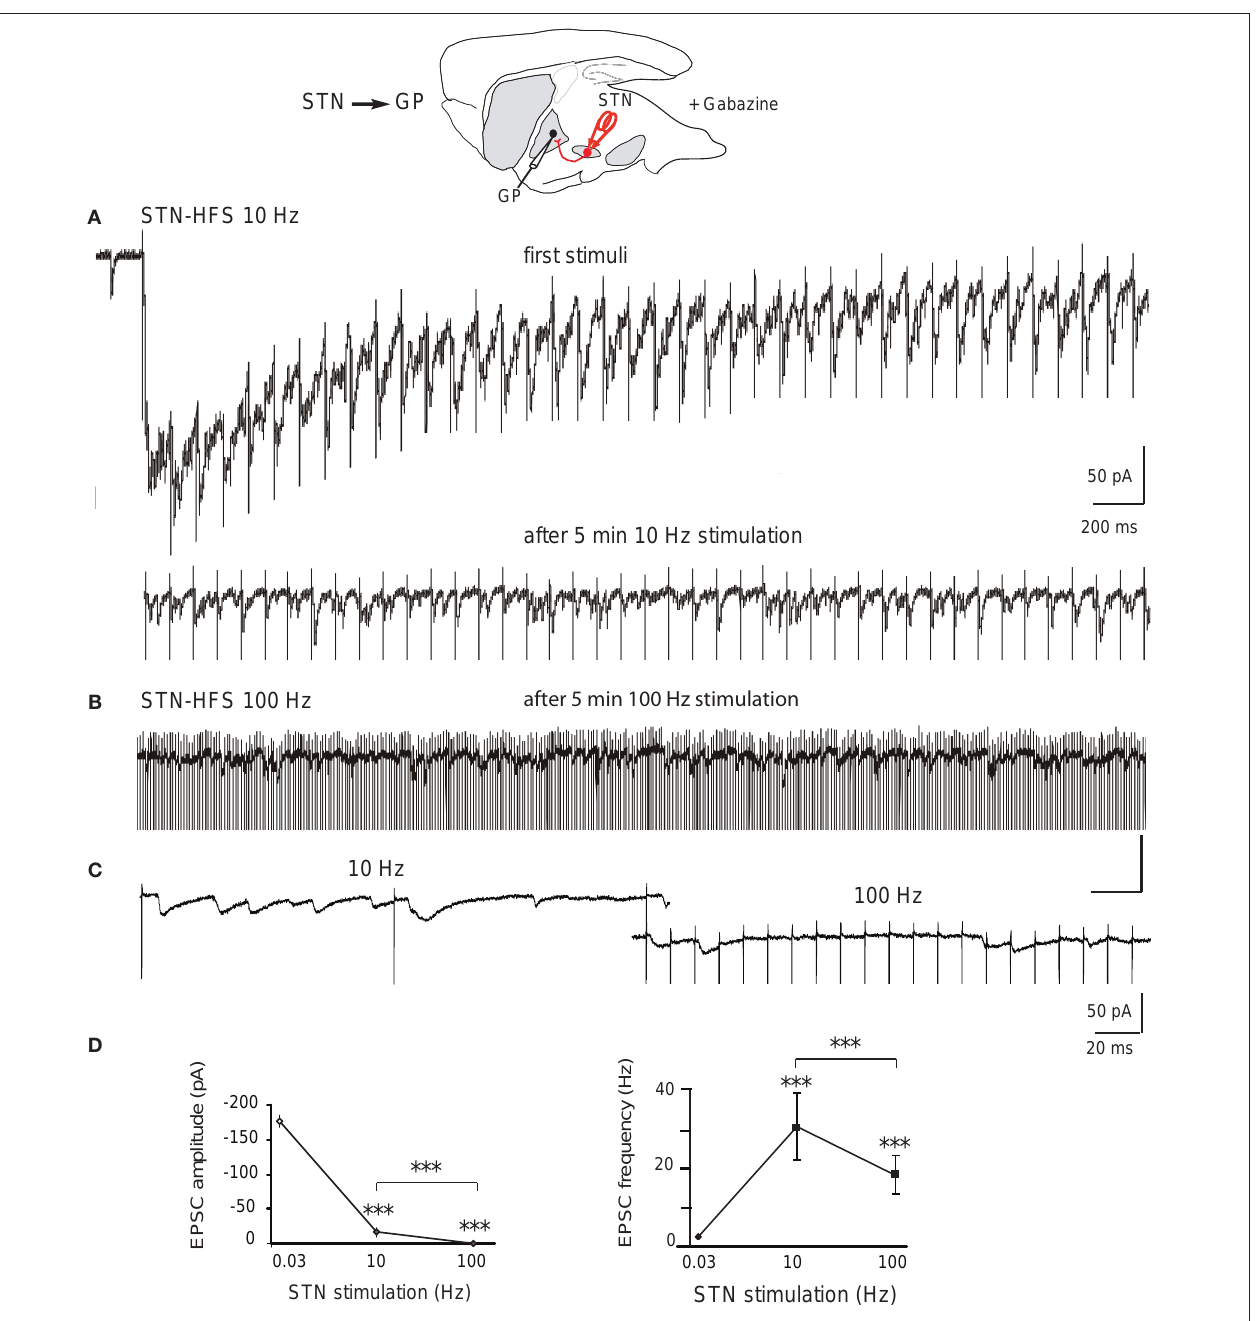
recorded in the same GP neuron as in (A) during STN-HFS at 100 Hz. (C) : Close up of traces under 10 and 100 Hz STN-HFS. (D) Averaged data showing the effects of 10 and 100 Hz STN stimulation compared to 0.03 Hz (control) on the amplitude and frequency of the EPSCs evoked in DA-depleted GP neurons. Each data point is the mean ± SEM. For the response at 0.03 Hz we considered the complex response as a whole and plotted its peak amplitude and frequency as if it were a single